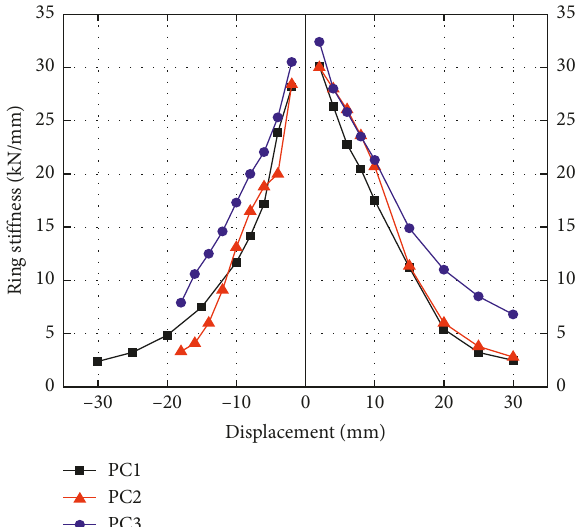
Figure 11: Ring stiffness-displacement